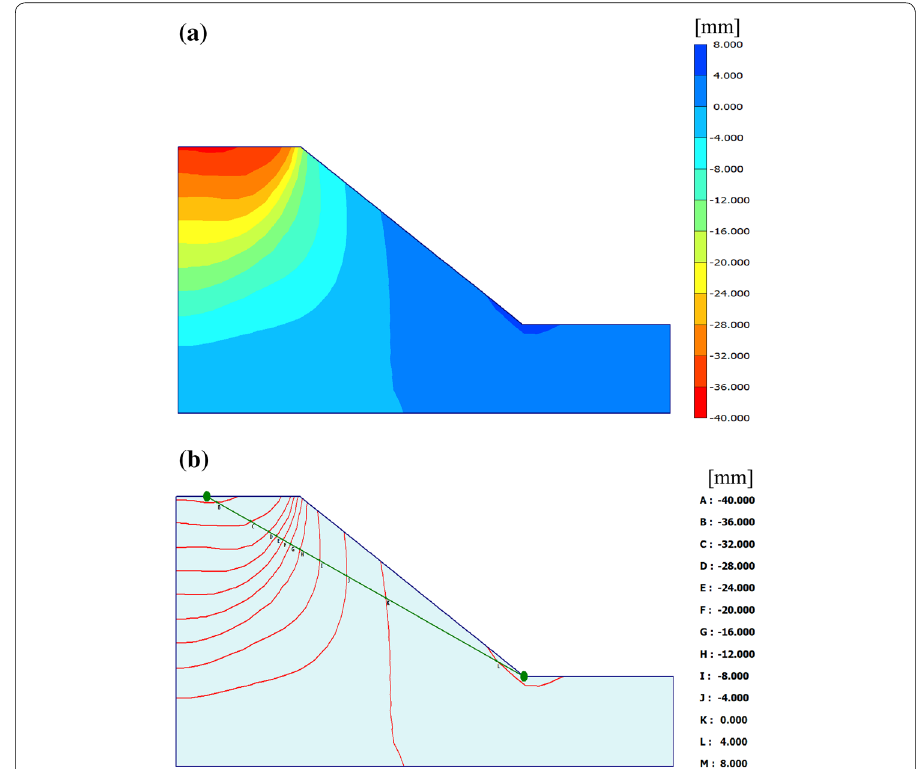
Fig. 16 Plot of vertical displacements β